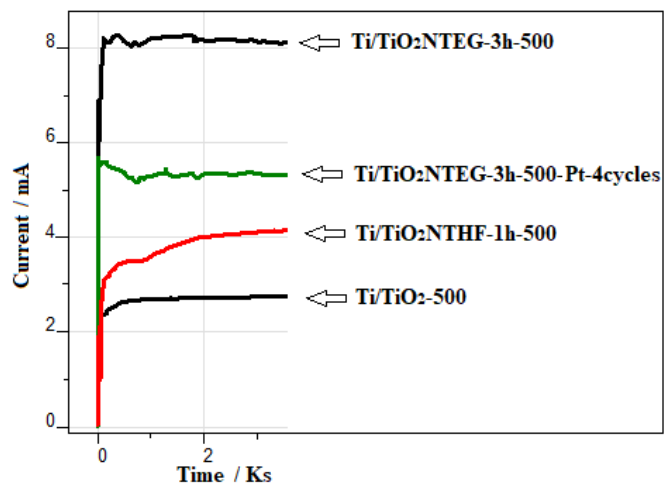
Figure 11. The photocurrent values of electrodes, prepared by different methods, in the same medium in which PEC paraquat degradation reactions were performed.